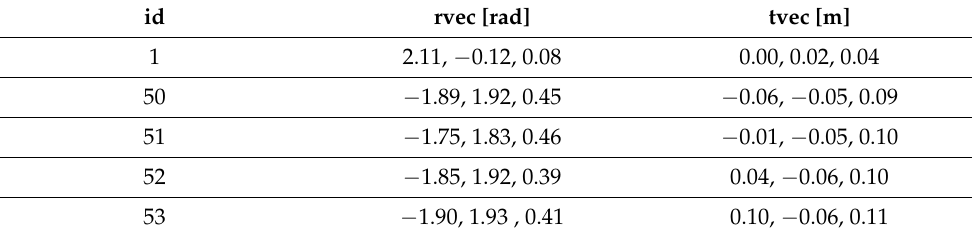
Figure 9. Detected ArUco markers and their corresponding reference frames identified by the OpenCV library. Table 1. ArUco relative pose arrays. The rvec values are in the axis–angle format in radians, and tvec are in